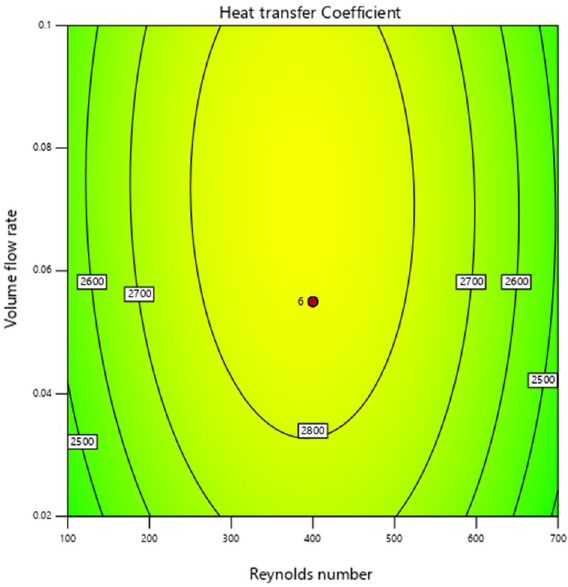
Figure 11. Heat transfer coefficient contour diagram influenced by volume friction and Reynolds number.